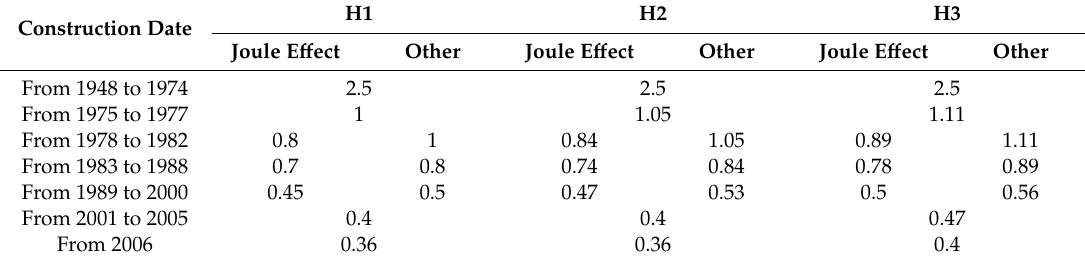
Table A3. Conductivity